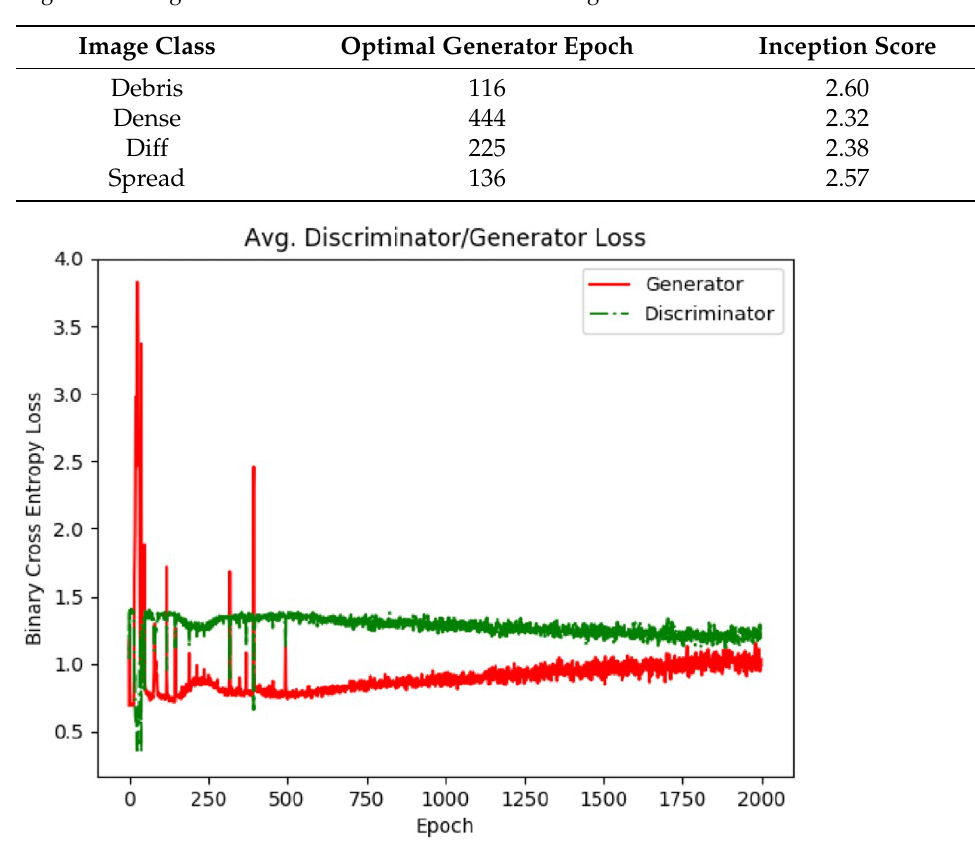
Figure 8. Generator and discriminator loss values for the dense class. As training progresses, the GAN reaches an equilibrium which is when training is considered finished. Using individual GAN models for each image class allows the GAN to be trained for different amounts of time based on the image